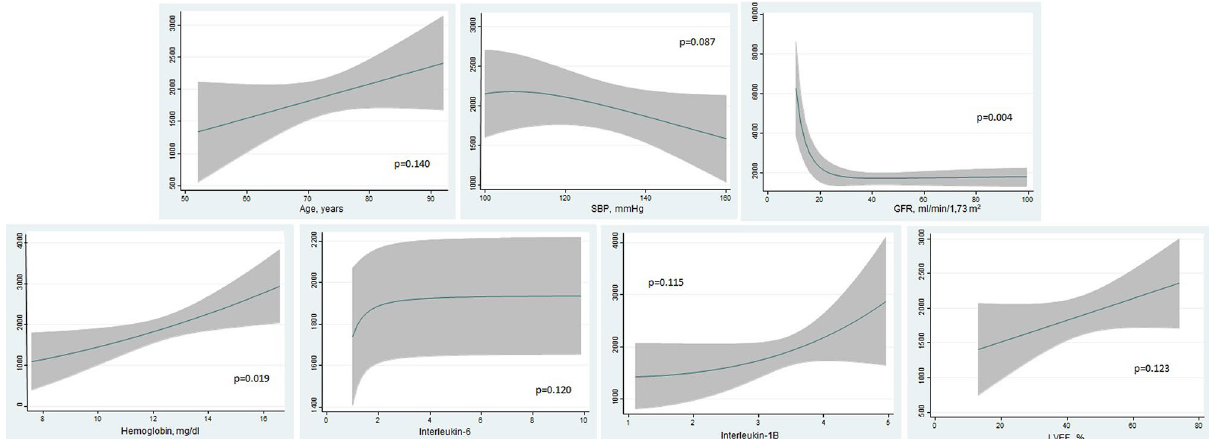
Figure 2. Direction and magnitude of the association among the covariates included in the multivariate Model 2 and AUC-H2. AUC-H2 Area under the curve of hydrogen concentration, SBP Systolic blood pressure, GFR Glomerular filtration rate, LVEF Left ventricular ejection